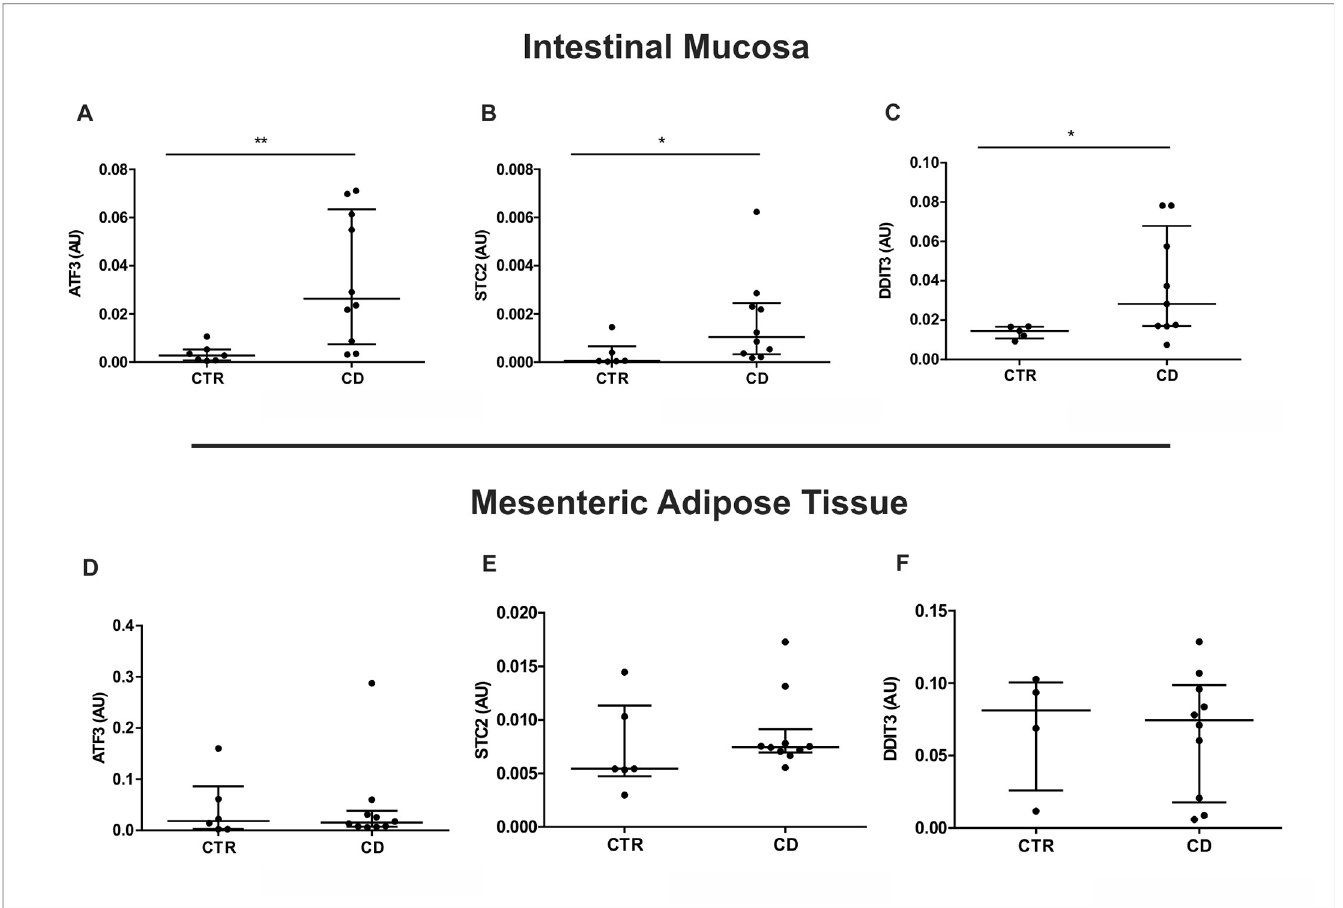
Fig 4. Activation of ER stress responsive genes in the intestinal mucosa and mesenteric adipose tissue (MAT) of Crohn’s disease patients. mRNA levels (qRT-PCR) of ATF3 (A), STC2 (B) and DDIT3 (C) were investigated in intestinal mucosa of CD patients (CD Group) compared to controls (CTR Group). mRNA levels (qRT-PCR) of ATF3 (D), STC2 (E) and DDIT3 (F) were evaluated in MAT of CD patients (CD Group) compared to controls (CTR Group). � p < 0.05 and �� p < 0.01 are considered statistically significant versus control group. AU: arbitrary